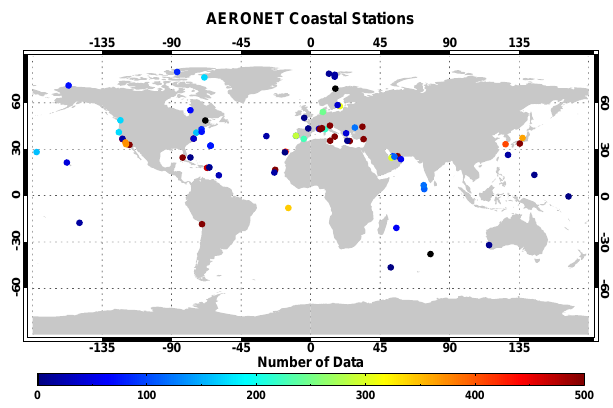
Fig. 2. Global distribution of AERONET sun/sky radiometers lo- cated in coastal areas (81 stations) used to archive aerosol optical properties for the test algorithm. The colors represent the number of inversion data points at each site. AERONET stations within 7km from the ocean were chosen as coastal